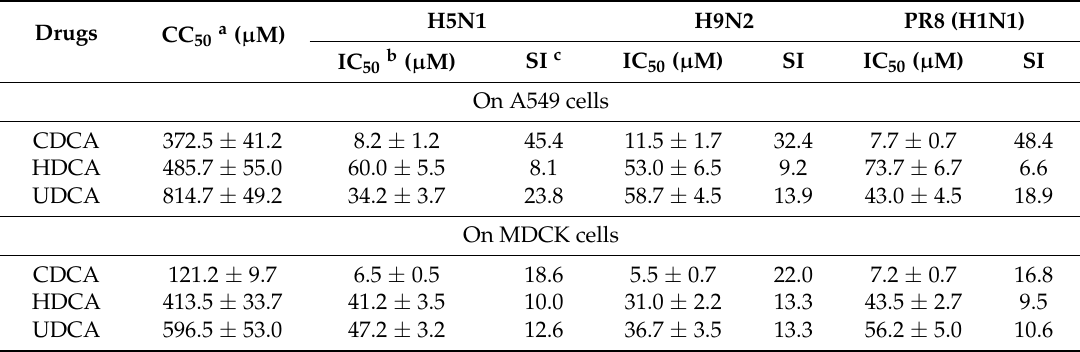
Figure 1. Chemical structure and cytotoxicity of chenodeoxycholic acid (CDCA). ( A ) Chemical structure of CDCA. ( B ) Cytotoxicity of CDCA on A549 cells. ( C ) Cytotoxicity of CDCA on MDCK cells. Confluent A549 or MDCK cells were treated with different concentrations of CDCA. After 48 h or 72 h, cell viability was measured by 3-(4,5-dimethylthiozol-2-yl)-3,5-dipheryl tetrazolium bromide (MTT) assay. The results are expressed as percentage (%) of mock treated cells (represented with PBS). Values represent the mean (%) ± SD from 3 independent determinations. * p < 0.05, ** p < 0.01 and *** p < 0.001 compared to the PBS control. Table 1. Cellular toxicity and inhibitory activity of CDCA, HDCA, and UDCA against influenza A virus replication in A549 and MDCK cells.